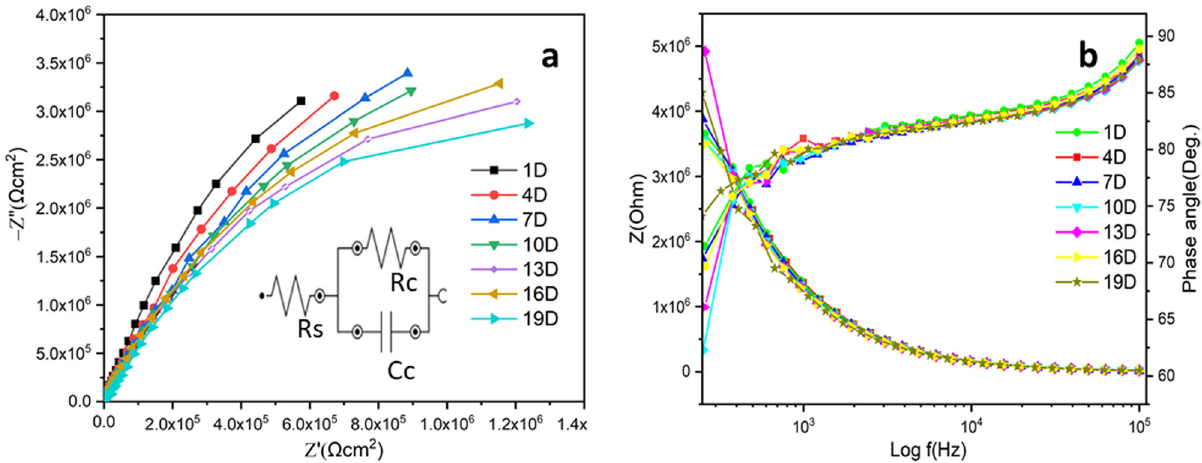
Figure 8: EIS ( a ) and Bodetheta ( b ) spectra of ROHA